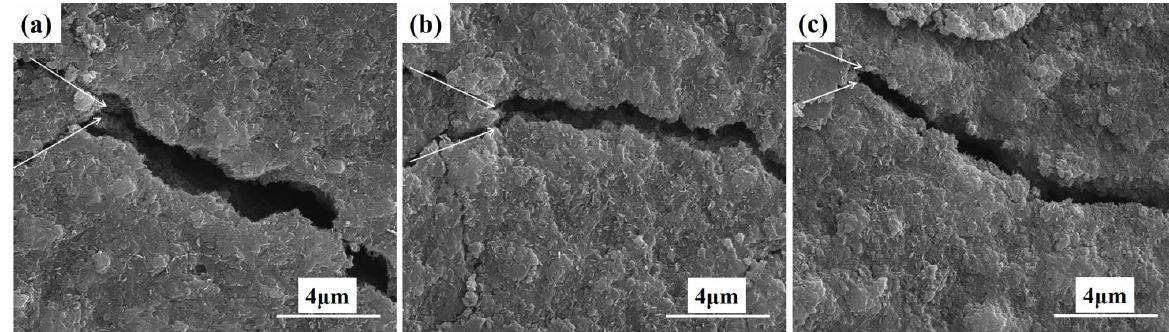
Fig. 3 Micro-crack propagation in Si 2 BC 3 N ceramics after an indentation test: (a) T0, (b) T1, and (c)